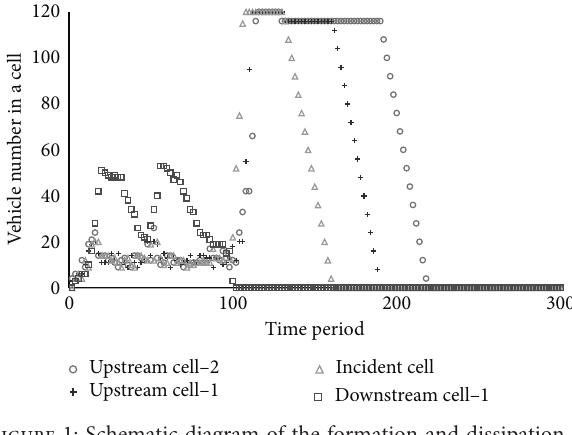
Figure 1: Schematic diagram of the formation and dissipation of congestion on the incident road